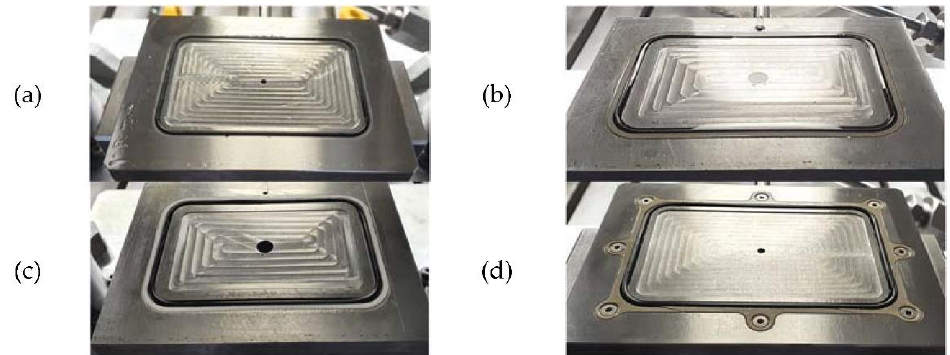
Figure 5. Filling plates with different sealing systems: ( a ) sealing with O-ring, ( b ) sealing with O-ring and milled one-piece support ring, ( c ) sealing with O-ring and 3D-printed one-piece support ring, ( d ) sealing with O-ring and milled multi-piece support ring.